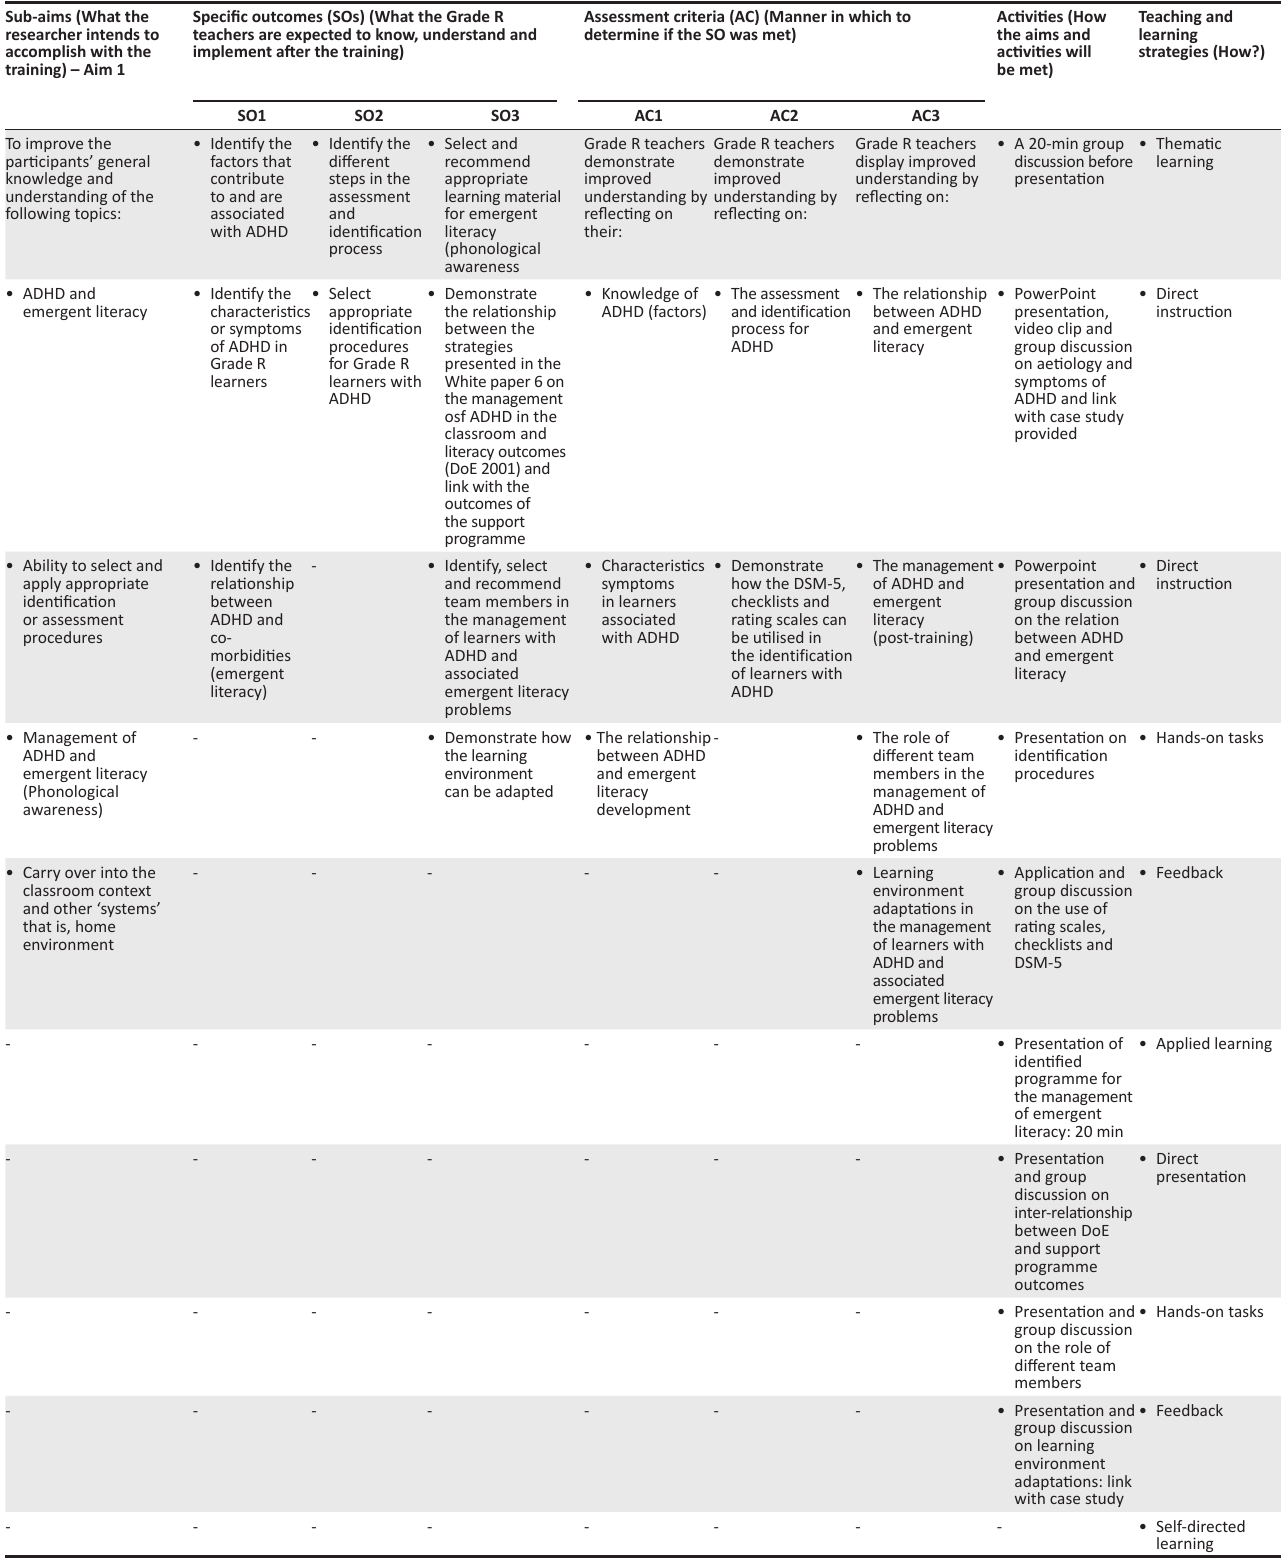
TABLE 2: Outline of the support programme: Aims, outcomes, assessment criteria, activities, teaching and learning strategies and assessment strategies. Sub-aims (What the researcher intends to accomplish with the training) – Aim